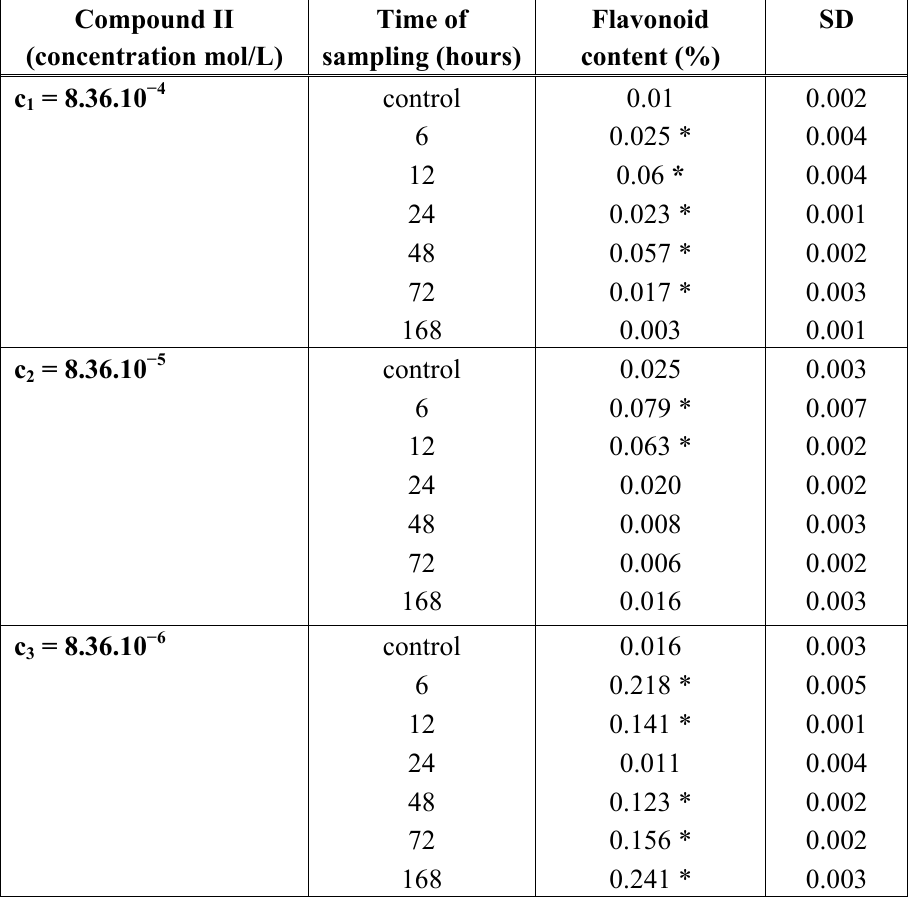
Table 4. Flavonoid content (%) in callus culture of Ononis arvensis